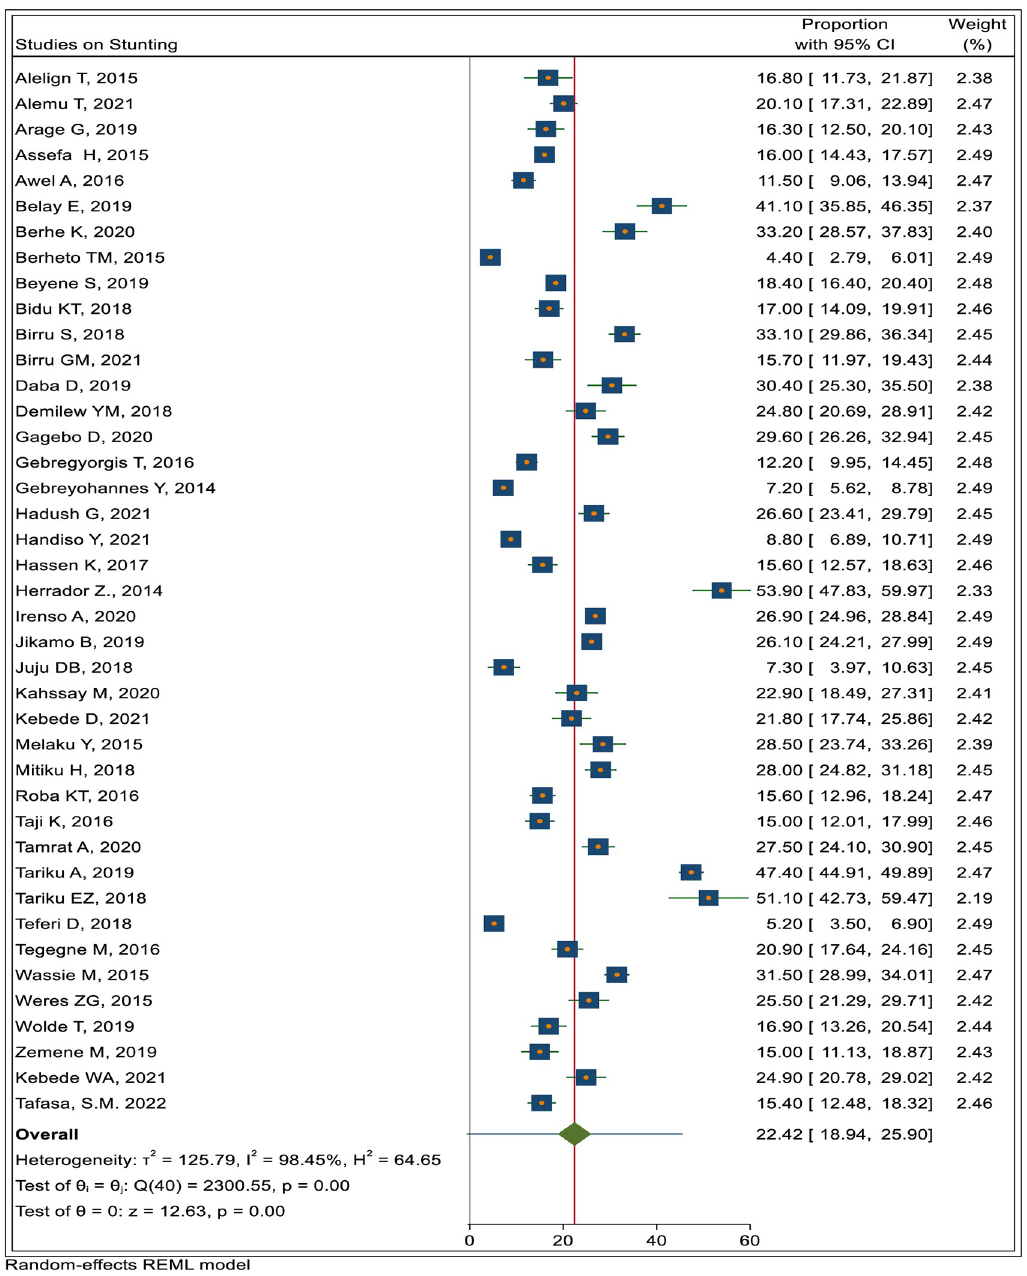
Fig 2. Pooled prevalence of adolescent stunting in